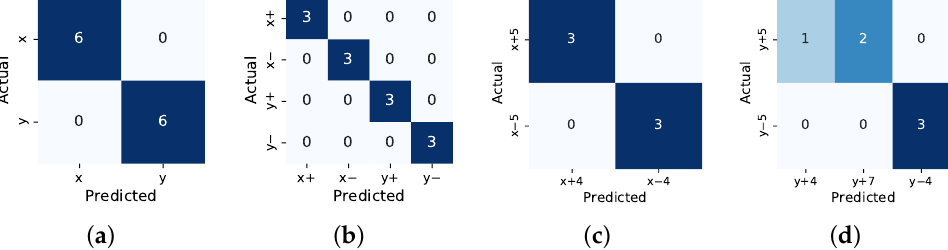
Figure 12. Confusion matrices for classification at different levels of the hierarchy. ( a ) First level of hierarchy ( x or y displacement). ( b ) Second level (negative or positive displacement). ( c ) Third level (magnitude of x displacement); ( d ) Third level (magnitude of y